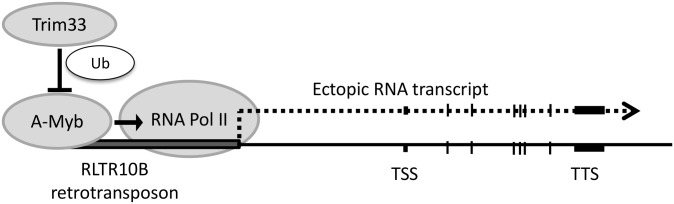
Model of Trim33 function at active RLTR10B retrotransposons in the testis.An RLTR10B element that acts as an alternative promoter of a nearby gene is shown. A-Myb recruits RNA Pol II and drives transcription. Trim33, acting as an E3 ubiquitin ligase, ubiquitinates and destabilises A-Myb, resulting in decreased expression of the locus.